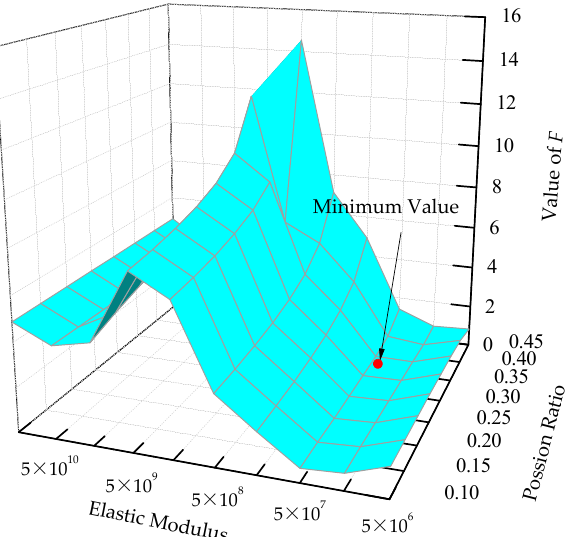
Figure 6. The variety of approximate functions with the identified soil parameters.